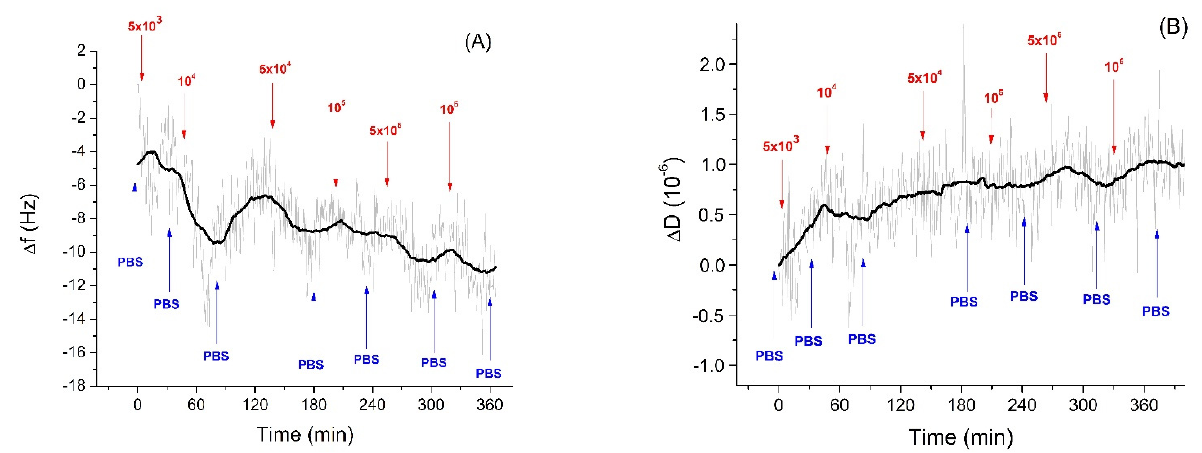
Figure 3. The kinetics of the changes of ( A ) fundamental frequency and ( B ) dissipation of the quartz crystal microbalance (QCM) transducer covered by neutravidin and aptamers following addition of Listeria innocua in various concentrations (in CFU/mL). The moment of addition of bacteria as well as washing of the surface by PBS are shown by arrows. Figure 3A was reproduced from [17].